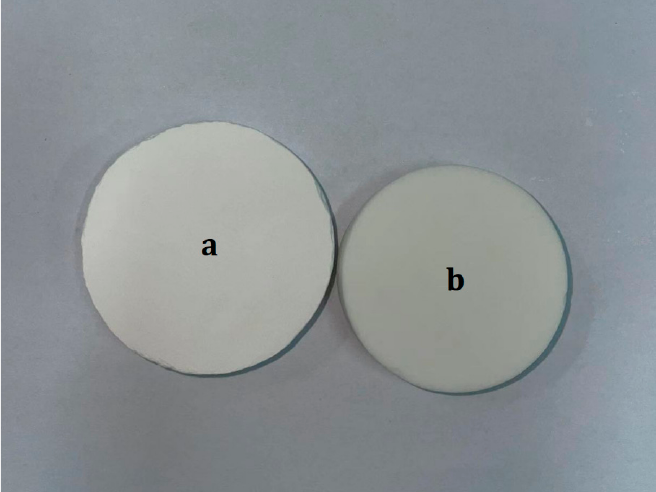
Figure 11. Comparison diagram of raw and clinker.